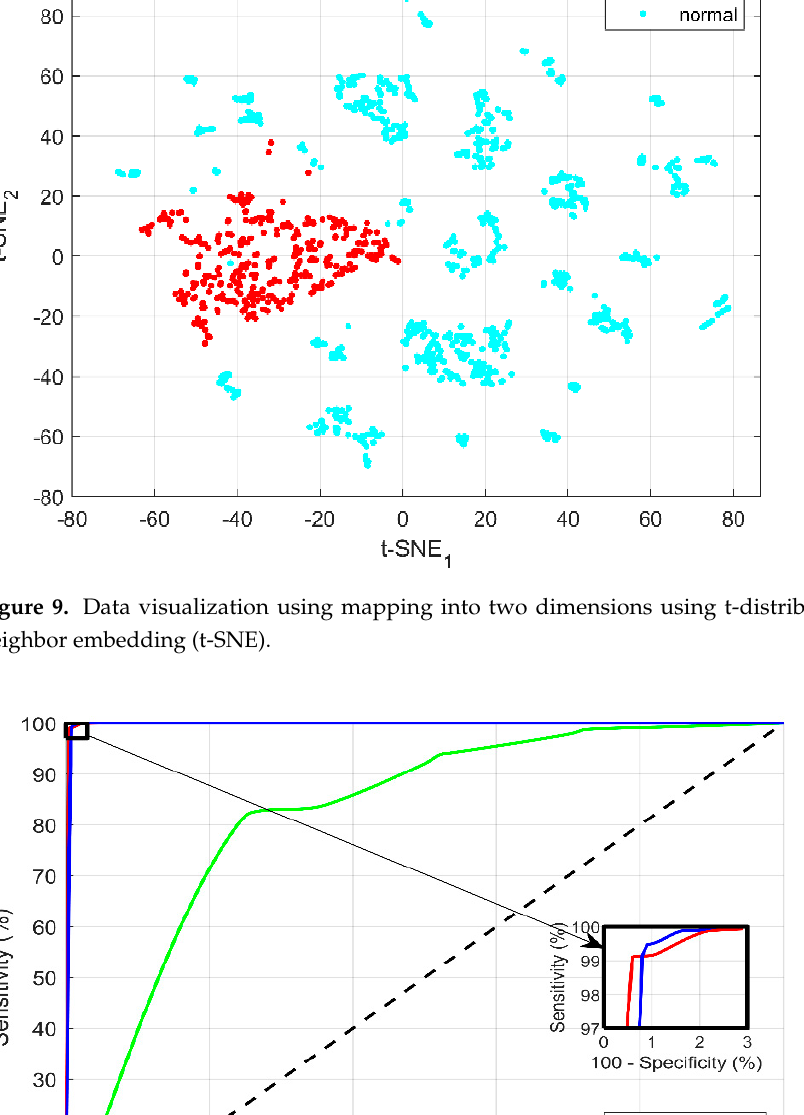
Figure 10. Receiver operating characteristic (ROC) curve showing the area under curve (AUC) curve for the original data as well as one-shot and two-shot learning based on the proposed Voronoi decomposition-based random region erasing (VDRRE) method.